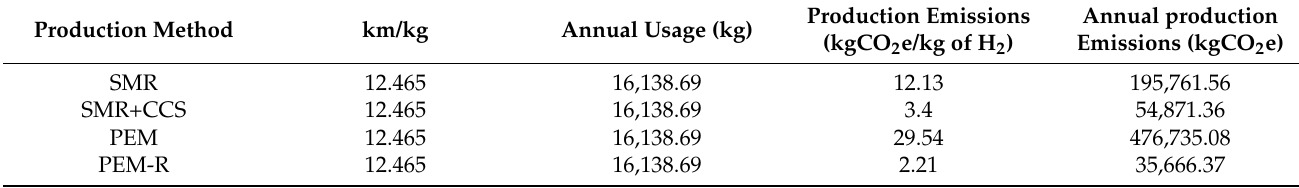
Table 9. Hydrogen Fuel Cell Powertrain Usage Calculations (Acronyms—SMR: Steam Methane Reforming, SMR+CCS: Steam Methane Reforming with Carbon Capture Storage, PEM: Proton-exchange Membrane Electrolysis, PEM-R: Proton- exchange Membrane Electrolysis with Renewable Sources.